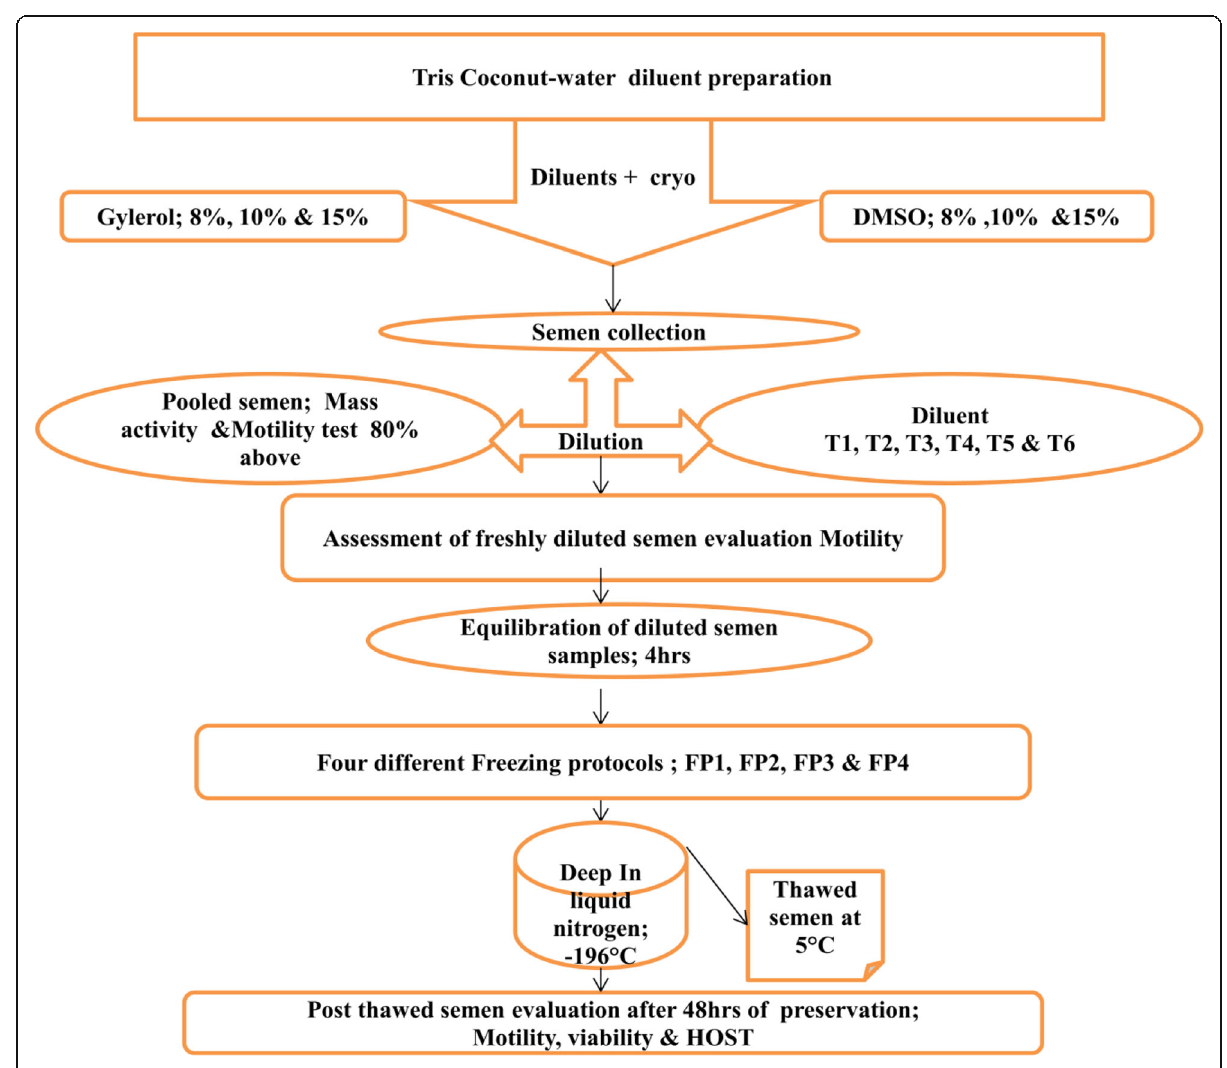
Fig. 1 Flow chart for rooster semen different freezing protocols for